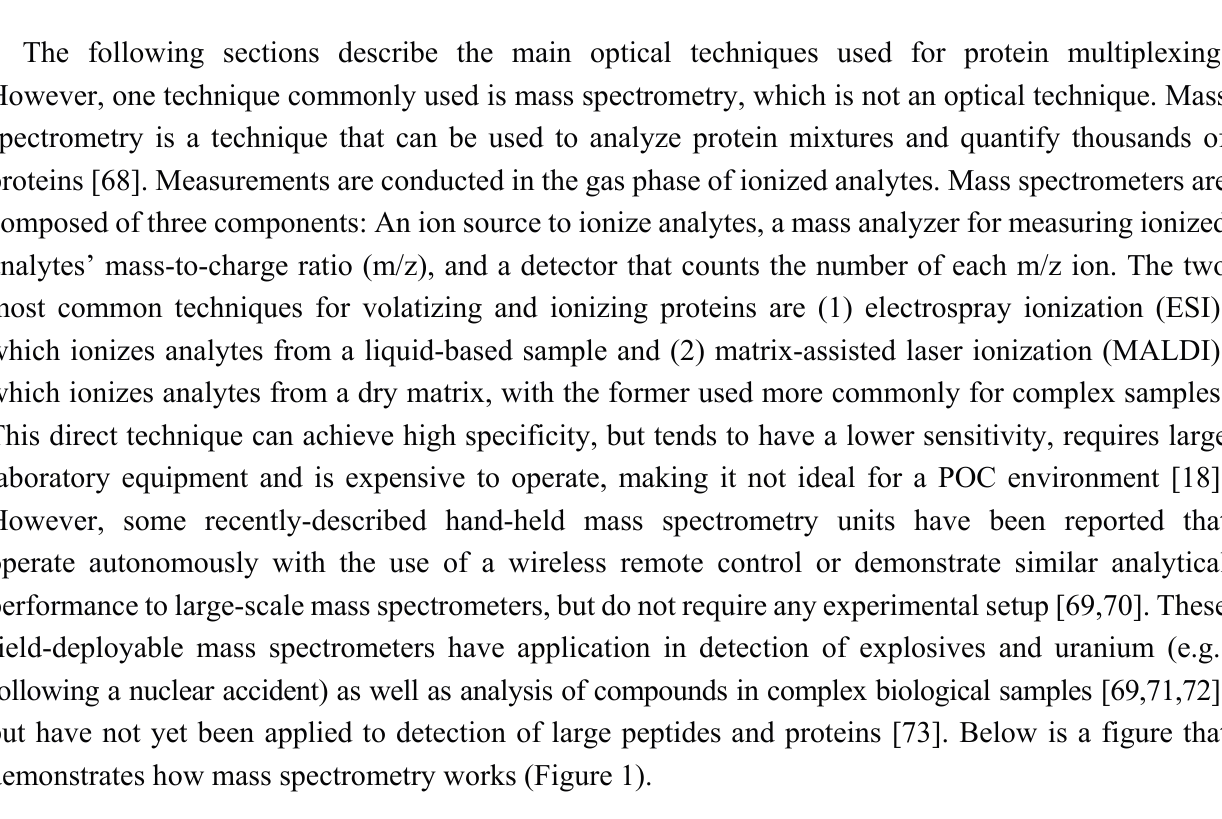
Figure 1. Mass spectrometry protocol [74] under license Philippe